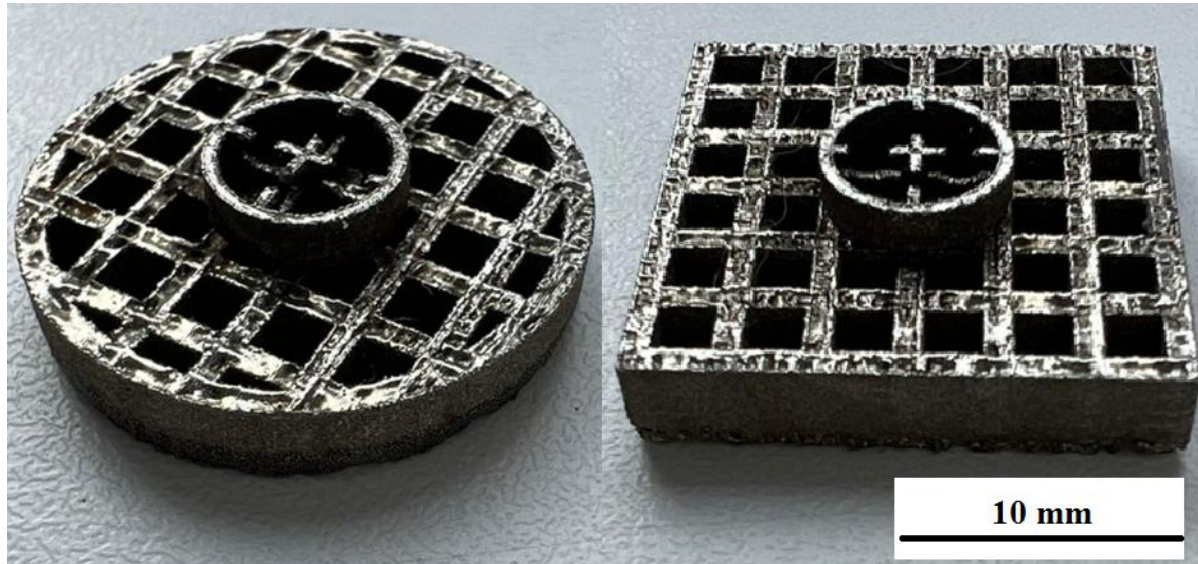
Figure 7. ET manufactured using SLM technology.